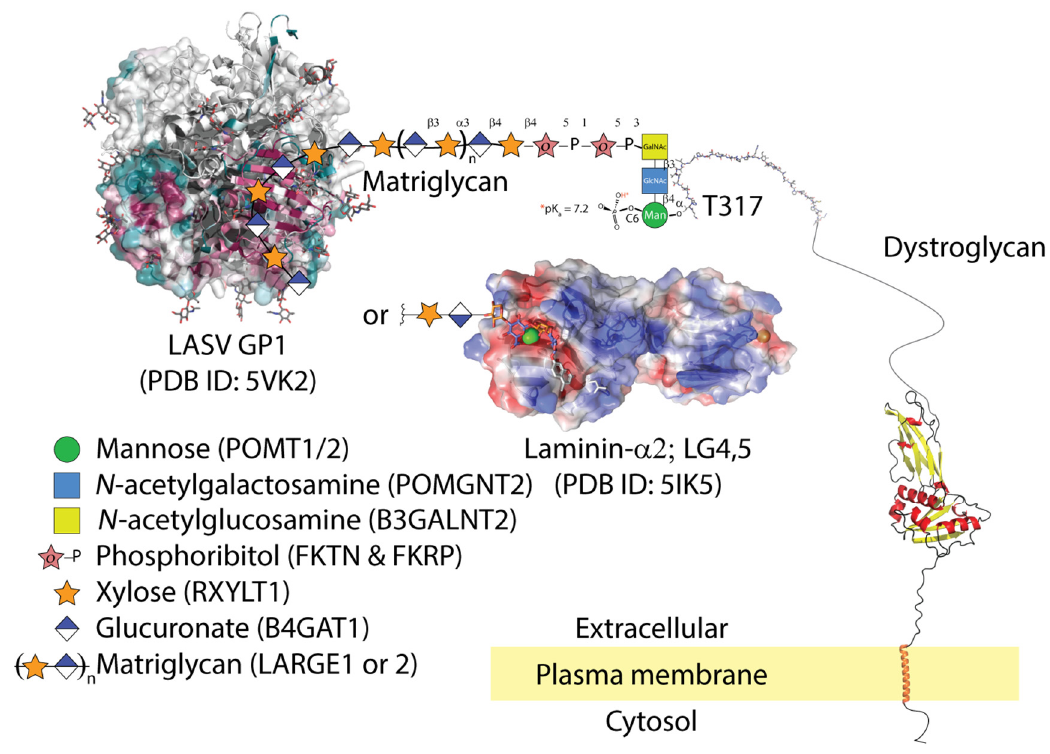
Figure 1. LASV GP1 is able to bind matriglycan (xylose and glucuronate), but only gains entry to cells that co ‐ express apoptotic phagocytic machinery. The molecular details of LASV GP1 binding to matriglycan are unknown. Matriglycan is polymerized on a primer of extended phosphocore M3 on threonine ‐ 317 and possibly 379 of α‐ dystroglycan. The core M3 trisaccharide is phosphorylated by Protein O ‐ Mannosyl Kinase (POMK); other glycosyltransferases are listed in parentheses next to their corresponding sugars. The conserved surface residues of LASV trimer from 5VK2 are shown as a gradient of magenta (conserved) to green (non ‐ conserved); (accessed on 6 July 2021: https://consurf.tau.ac.il/). LASV GP1 binding displaces LG domains from matriglycan. The semi ‐ transparent electrostatic surface of LG4 ‐ 5 domains from laminin ‐ 2 α is shown binding a unit of xylose ‐ glucuronate via calcium (green sphere). Parts of the dystroglycan structure were downloaded from AlphaFold [26].